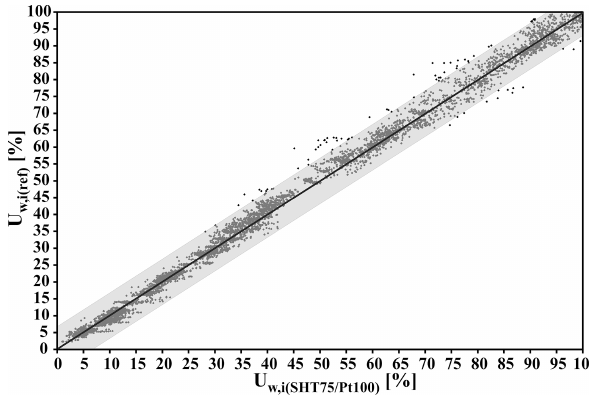
Figure 10. All measurements at all temperatures; the area marked in grey is the confidence interval ( ± 7%) of U w , i (SHT 75 /Pt 100 ) cal- culated with Eqs. (6)–(9) and U w , i ( ref ) calculated with Eq.